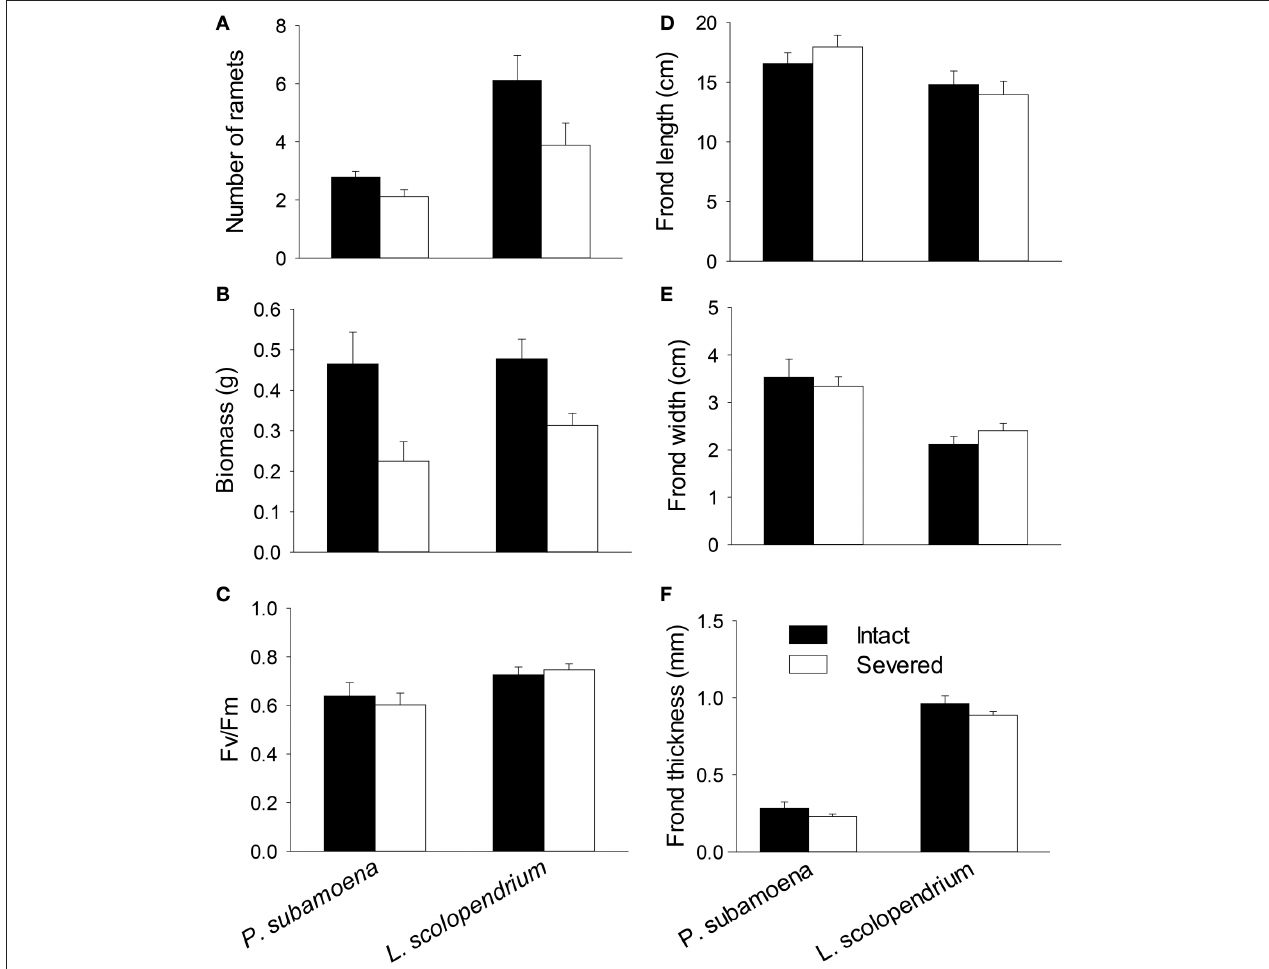
FIGURE 2 | Effects of rhizome severing on (A) ramet number, (B) biomass, (C) F v /F m , (D–F) and frond morphology of the two epiphytic ferns in the group experiment. Error bars represent SEs.